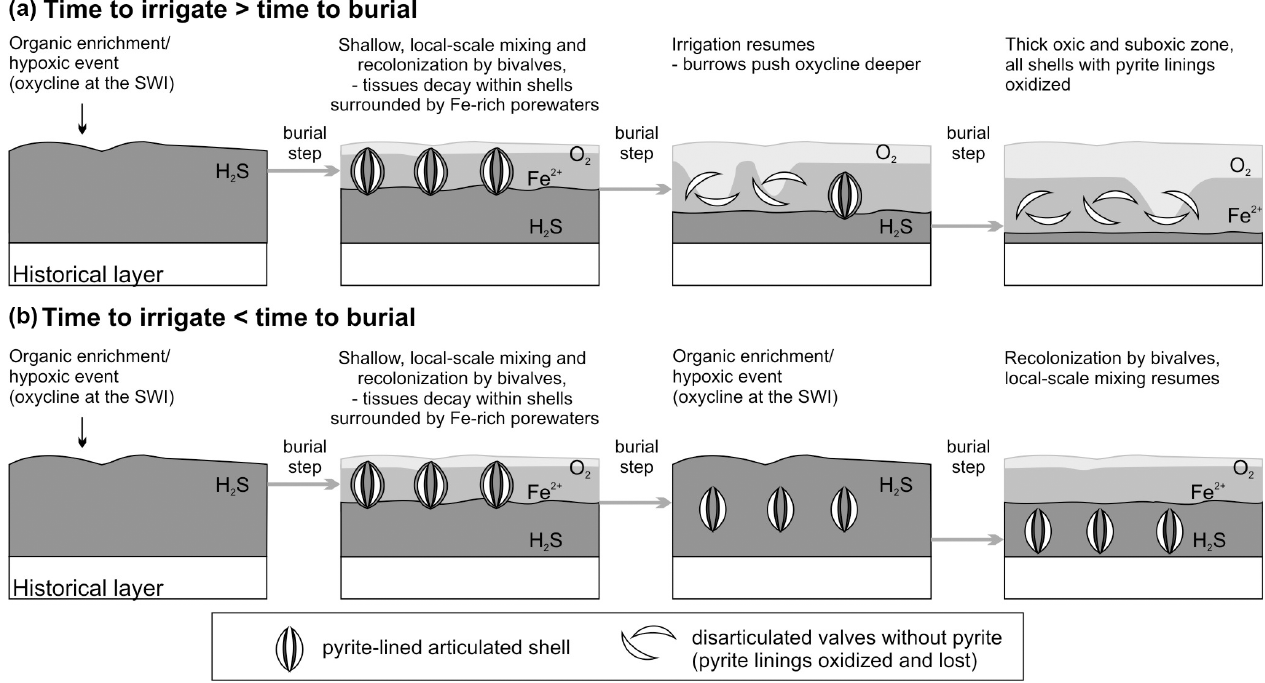
Figure 16. Two pathways characterized by differences in the frequency of hypoxic events (leading to the local extinction of infaunal or- ganisms) and by differences in recovery rate of infaunal communities with high irrigation potential. As bivalves colonize and die at shallow sediment zones, both pathways promote the initial formation of reduced pockets, surrounded by iron-rich porewaters induced by local-scale mixing during the early recovery phase. (a) In the aftermath of hypoxia, pyrite linings in reduced pockets are formed initially in mixed sediments, but these are recycled under later recovery of irrigating organisms that oxidize deeper sediment zones and contribute to disinte- gration of initially articulated shells. (b) If the frequency of hypoxic events is high, the oxycline can remain permanently shallow because the recovery of infauna with high bioirrigation potential remains patchy, and some subset of shells with pyrite linings is thus not oxidized. Therefore, shells with pyrite linings can escape from the mixed layer into the subsurface stratigraphic record in (b) . In the historical layer, valves permanently remain in reducing